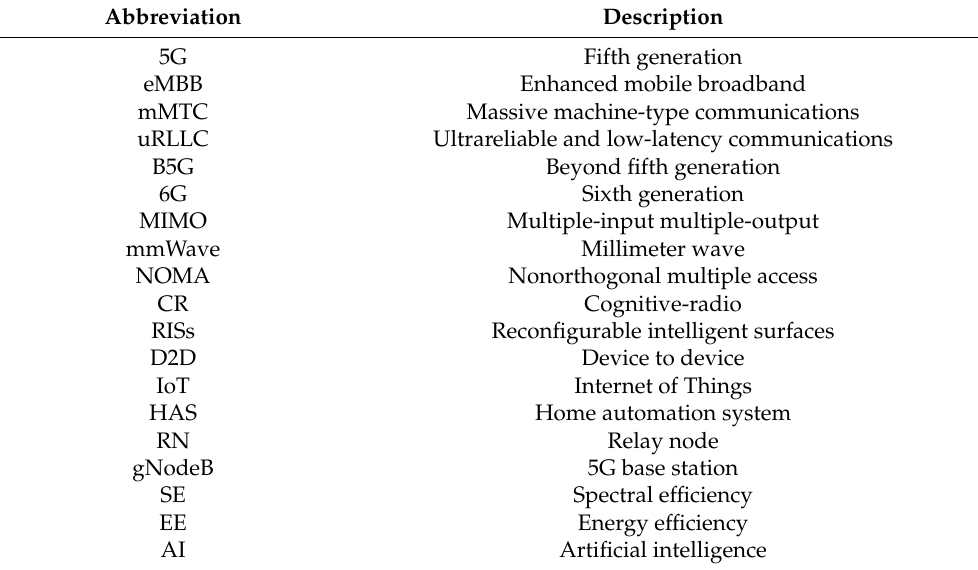
Table 1. List of